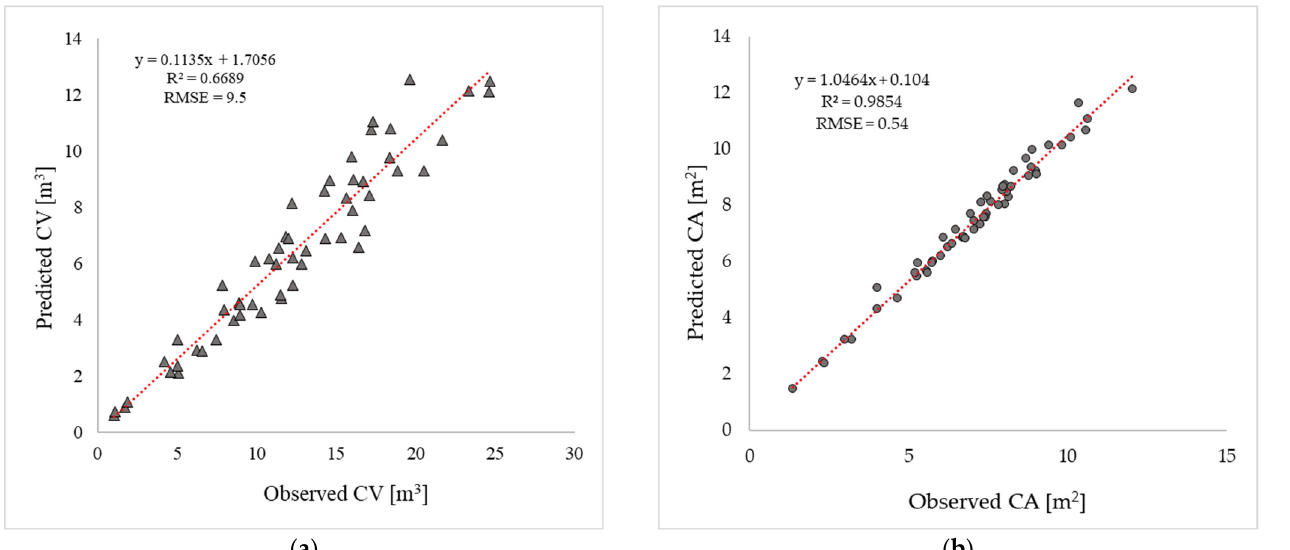
Figure 14. ( a ) Comparison between ground measured and UAV-estimated CV; ( b ) comparison between ground measured and UAV-estimated CA.